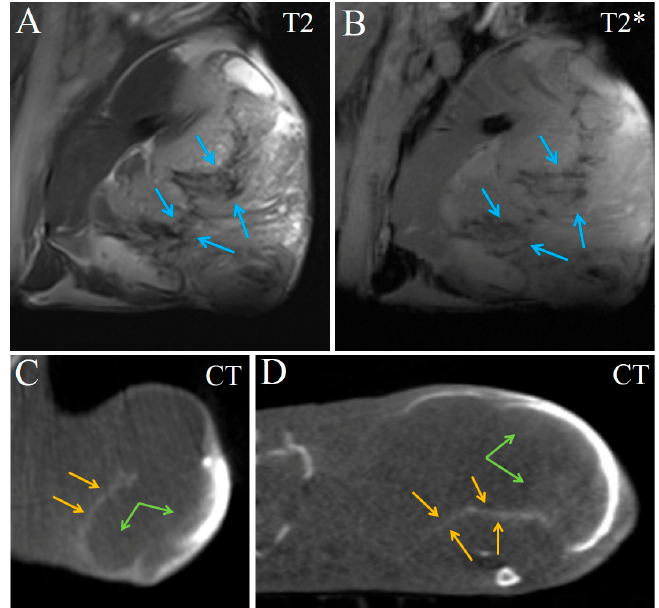
Figure 9. Images of Ca755 mammary carcinoma at 17 days post injection of Fe 3 O 4 @Au. ( A ) T2 MRI, coronal image; ( B ) T2* MRI, coronal image. Blue arrows mark necrotic regions; ( C ) CT, coronal image; ( D ) CT, transversal image. Orange arrows indicate the connective tissue septa, green arrows indicate the area of nanoparticle accumulation.